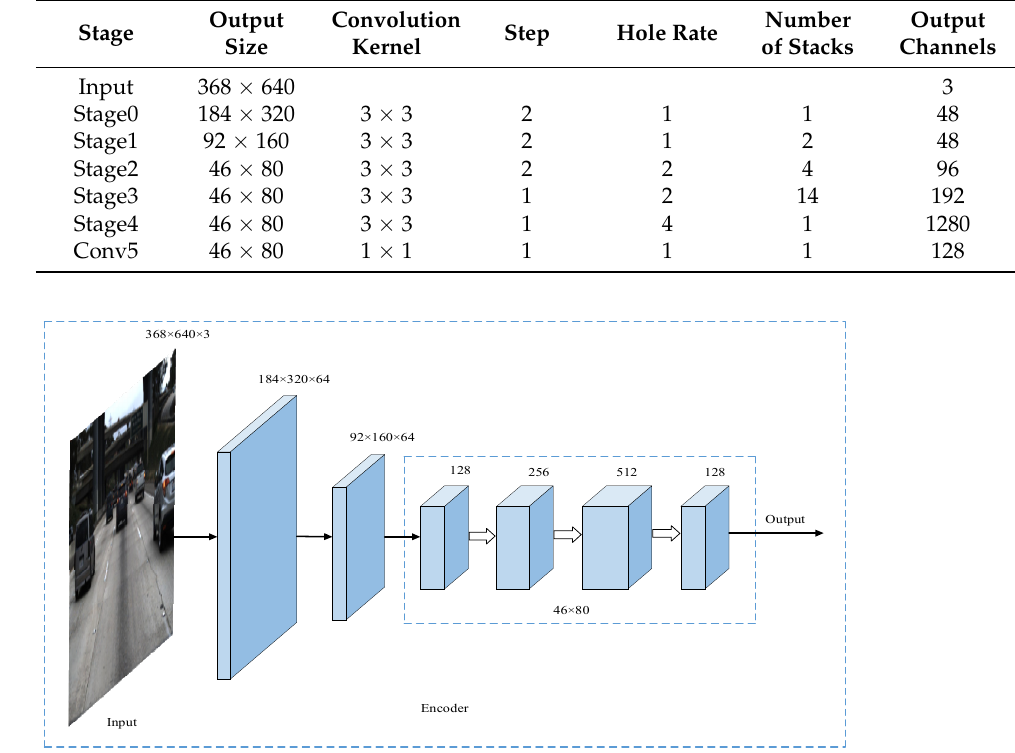
Figure 1. Improved encoder network structure diagram.